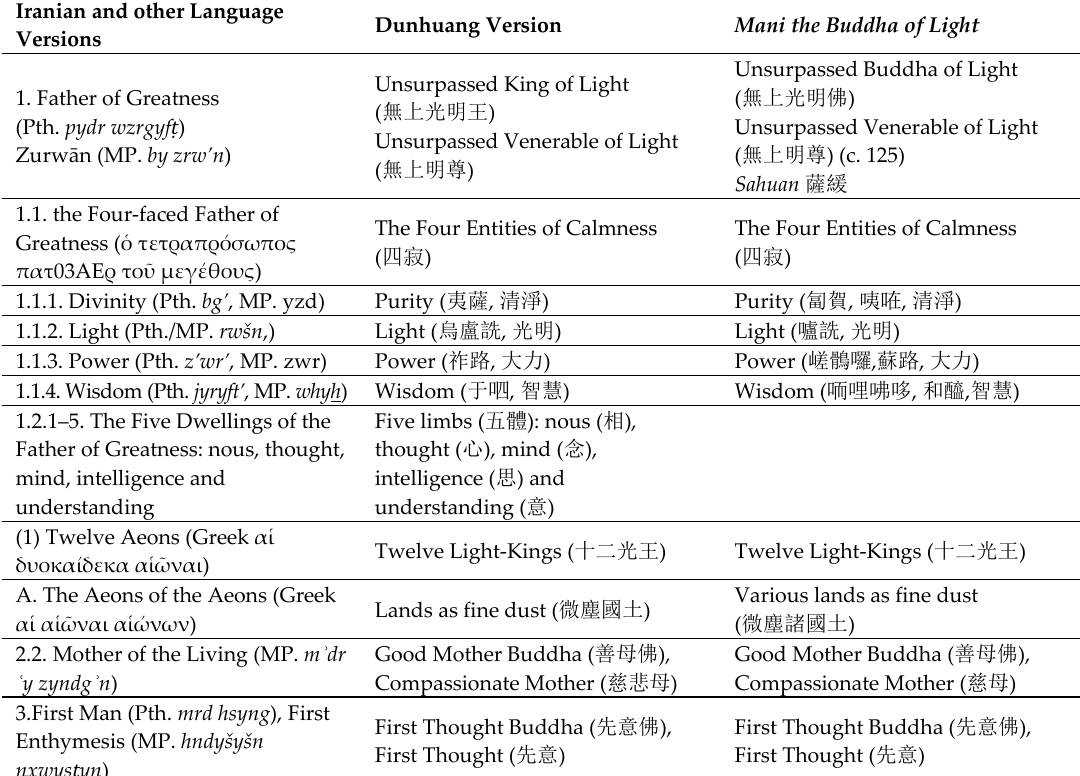
Table 1. Table of Simplified Manichaean Pantheon.